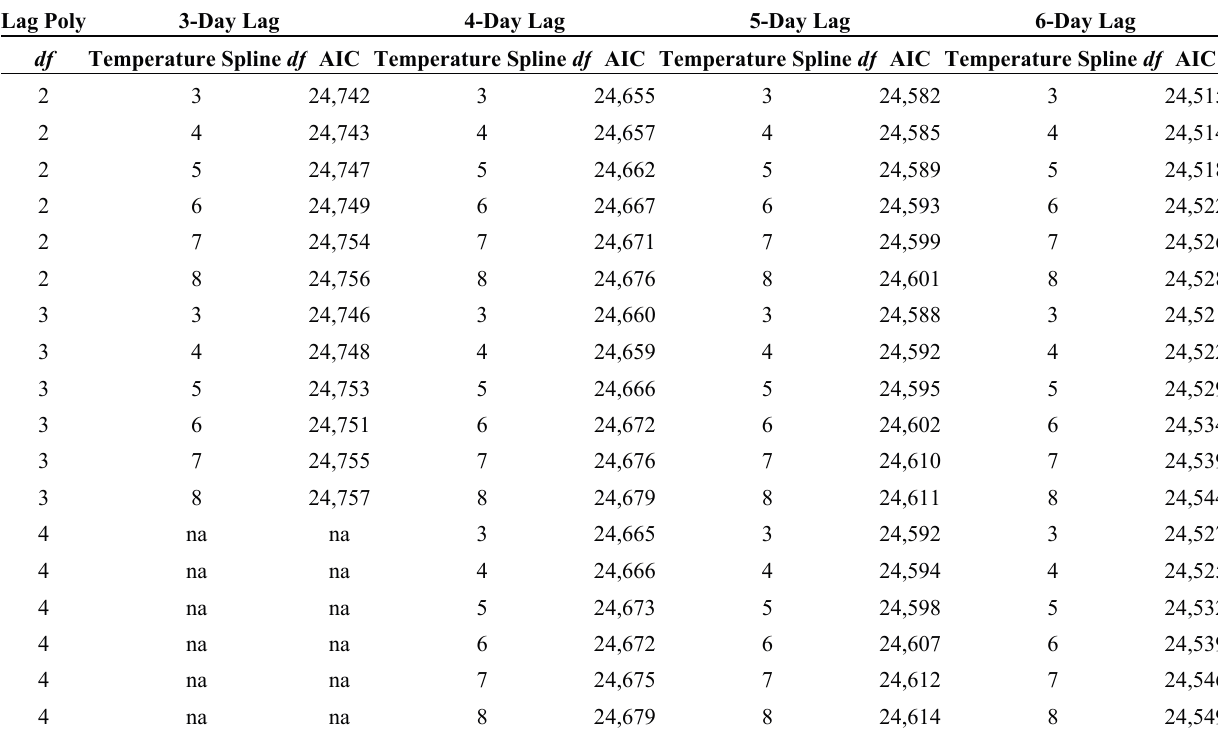
Table 2. AIC values for the DLNM using Toronto maximum daily temperatures with various lag durations (3–6 days), lag polynomial function degrees of freedom (2–4), and temperature spline degrees of freedom (3–8). 3-Day Lag 4-Day